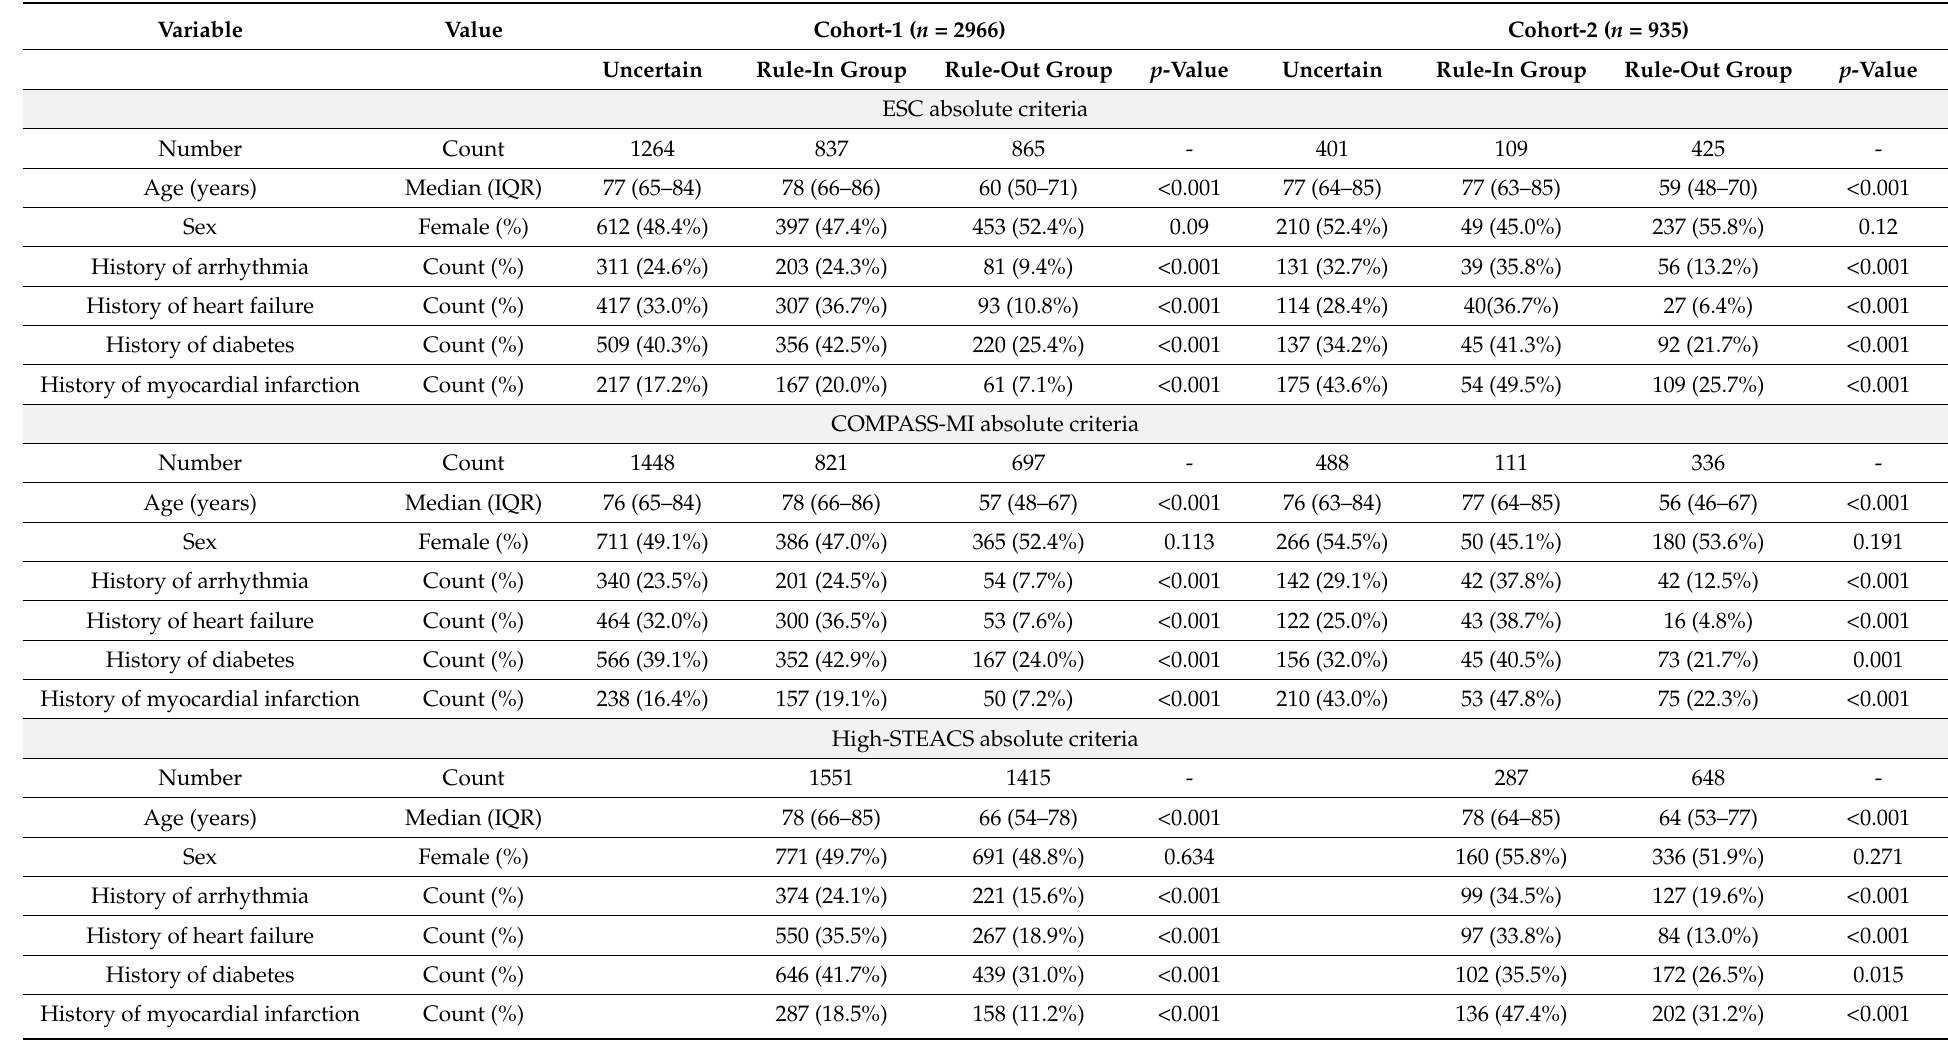
Table 2. Demographics and clinical history of the two ED cohorts characterized by the different rule-out and rule-in hsTnI